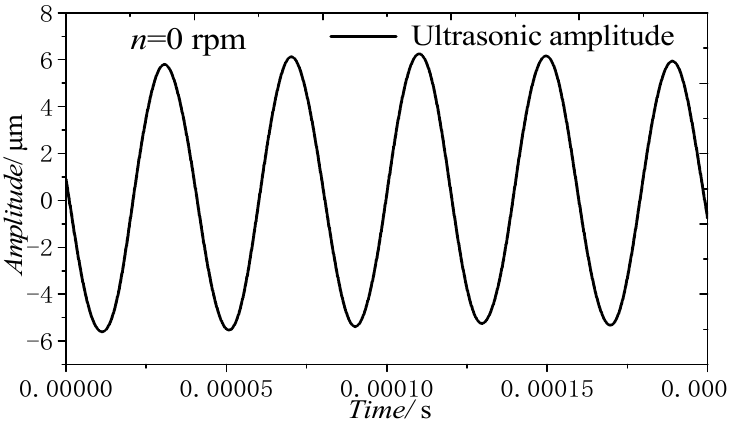
Figure 10. Ultrasonic vibration static amplitude. Figure 11 shows the actual amplitude curve when the grinding speed was 5.03 m/s, the feed speed was 1100 mm/min, and the depth of cut was 29 µ m. The amplitude after filtering was 4.6 µ m, whereas the amplitude without load was reduced by 1.2 µ m. The preceding research shows that this method of measuring amplitude can effectively measure the AA of the grinding process in real time.